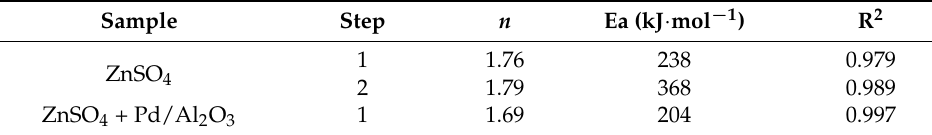
Table 1. Estimated kinetic parameters and corresponding correlation coefficient (R 2 Table 1 . Estimated kinetic parameters and corresponding correlation coefficient (R 2 ).